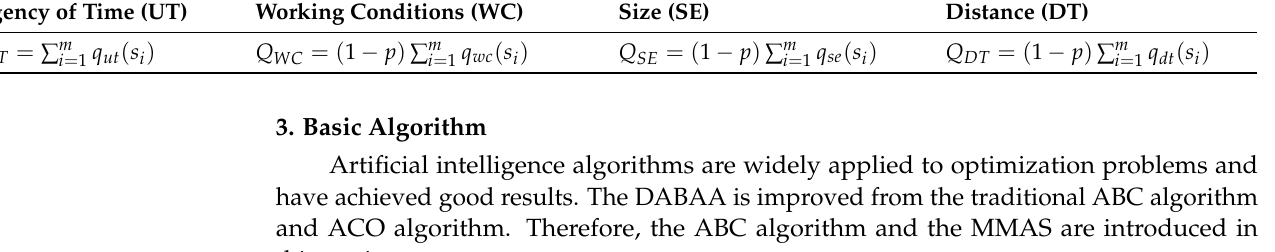
Table 1. QoS aggregate formula. Urgency of Time (UT) Working Conditions (WC) Size (SE) Distance